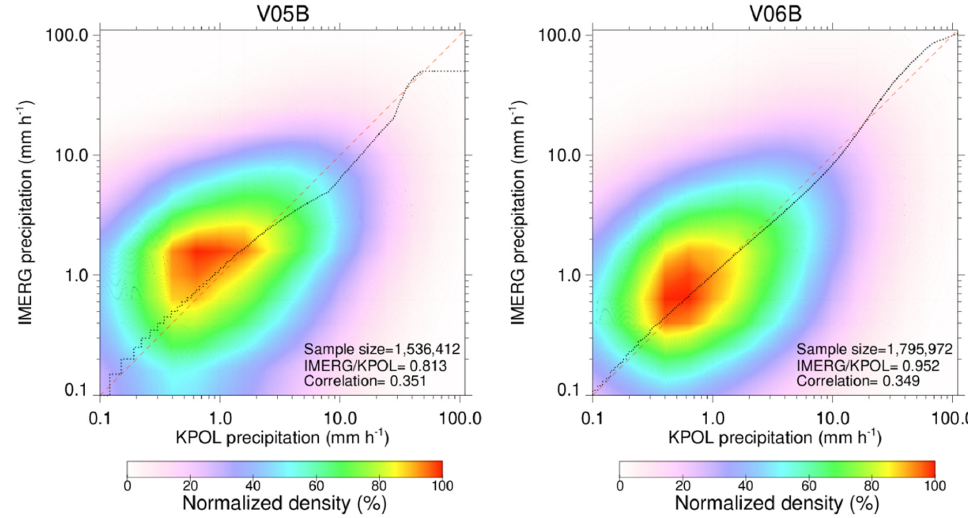
Figure 12. Same as Figure 10 but for precipitation rates from IMERG V05B and V06B, respectively, regardless of sources.